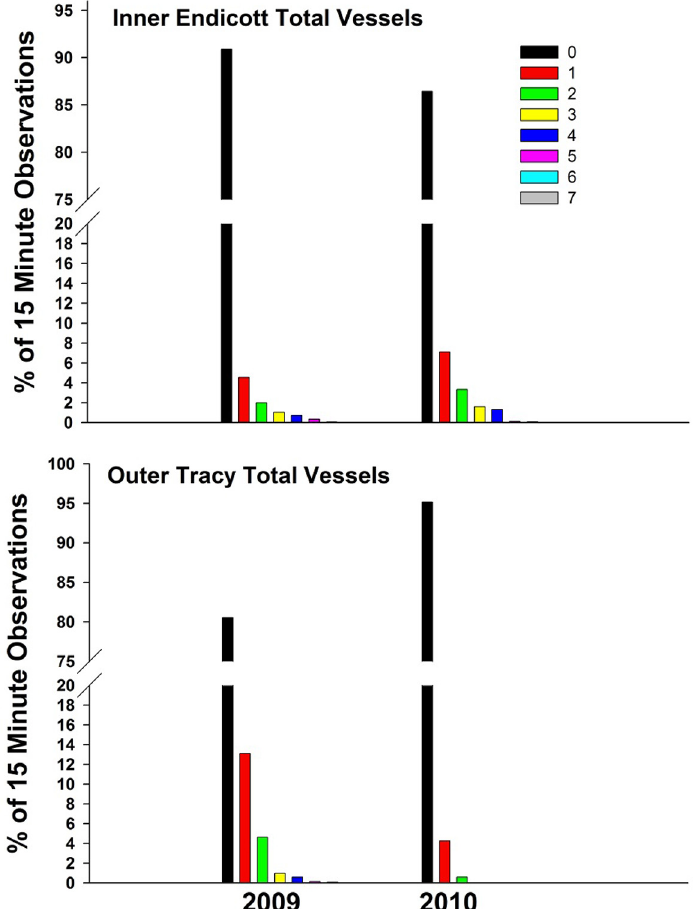
Fig 4. Percentage of observations when vessels were observed in the study area. Percent of 15 minute observation periods in which zero, one, or more vessels (all vessel-types combined) were present in inner Endicott Arm and in Tracy Arm in 2009 and 2010. Outer Endicott is omitted because vessels generally moved through the area to reach the inner